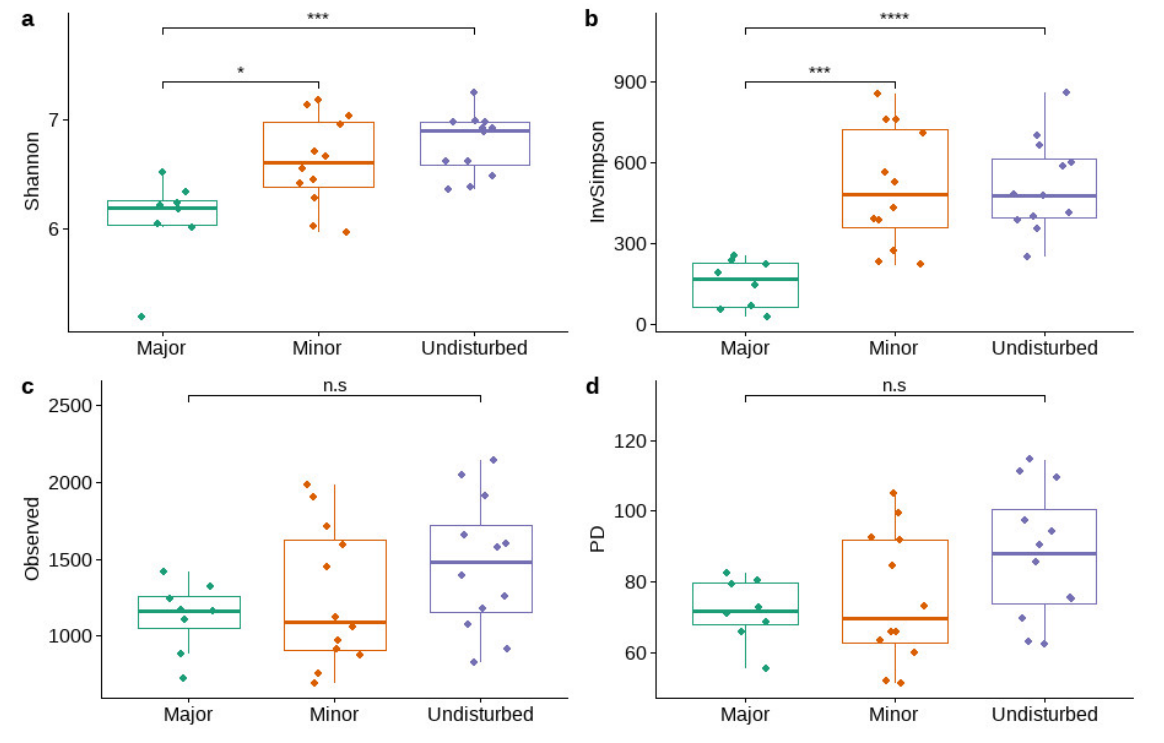
Figure 5. Alpha diversity metrics (( a )—Shannon index, ( b )—Inverse Simpson index, ( c )—observed species, ( d )—Faith’s phylogenetic diversity) for sites of different disturbance levels. Asterisks above the bar plots indicate the statistically significant differences between the levels of disturbance based on one-way ANOVA (not significant (n.s): p > 0.05; *: p ≤ 0.05; ***: p ≤0.001; ****: p ≤0.0001).